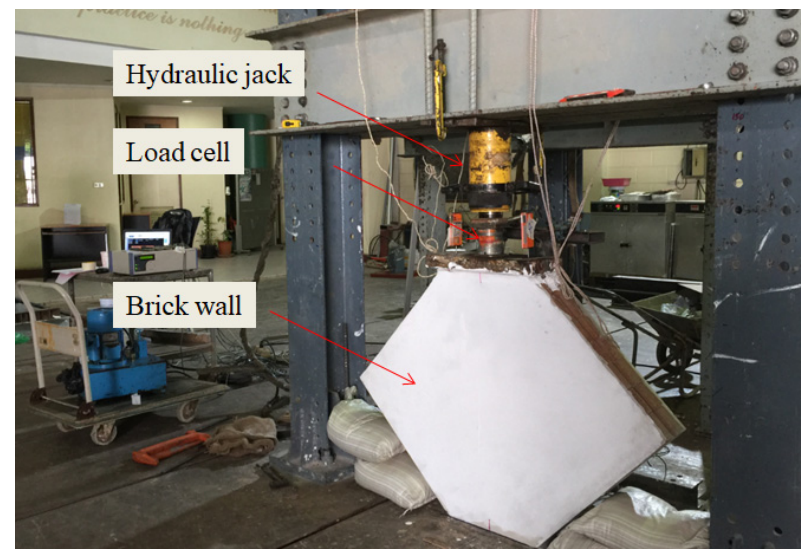
Figure 12. Loading setup.